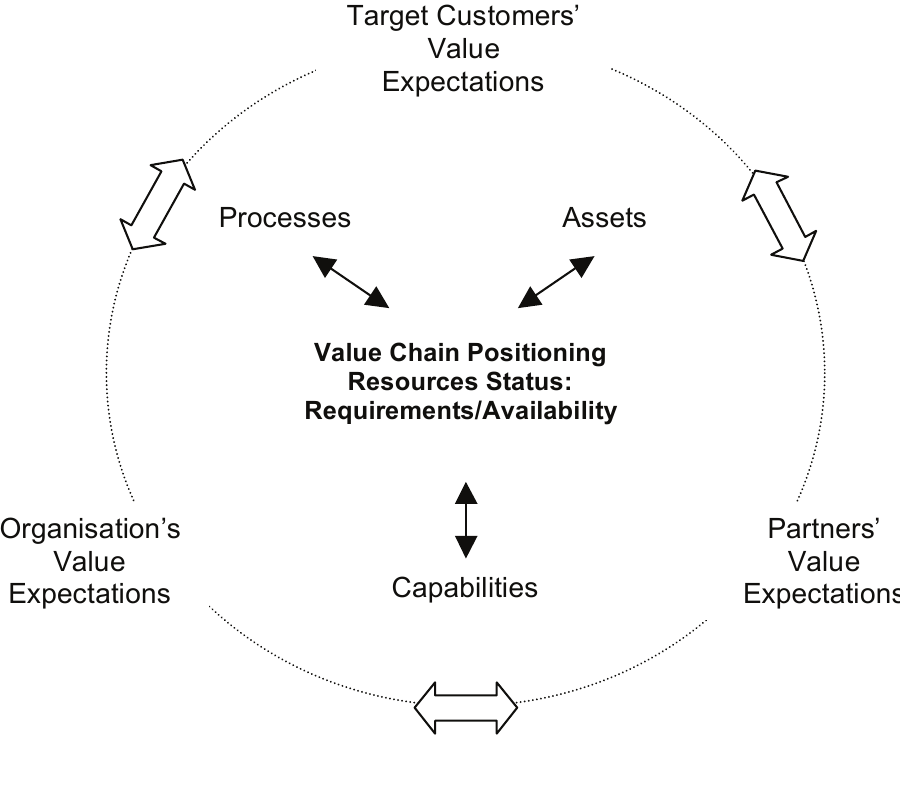
Figure 3: Matching value chain member objectives and resource requirements and availability